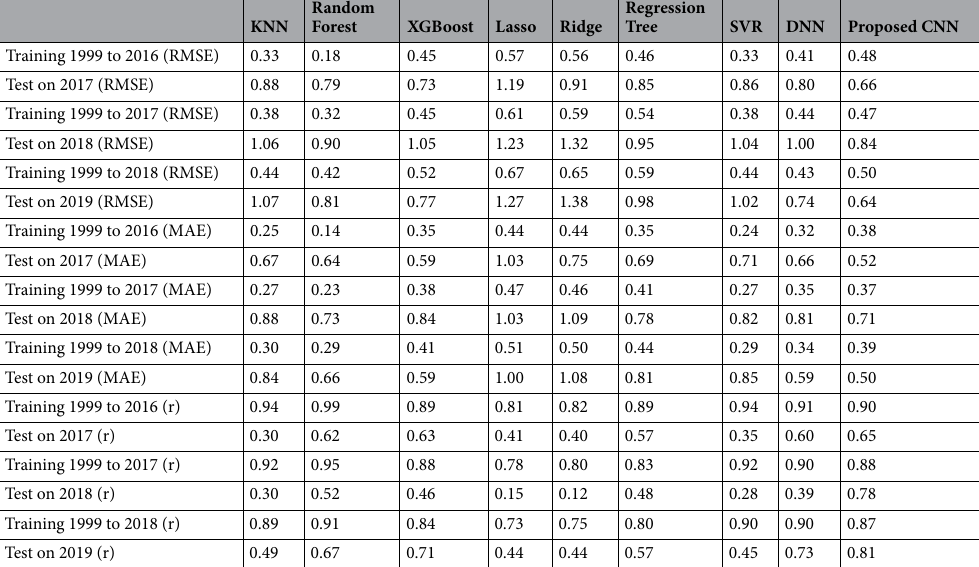
Table 1. Training and validation results (RMSE, MAE, and r (correlation coefficient)) of the baseline machine learning models and the proposed CNN model to predict winter wheat